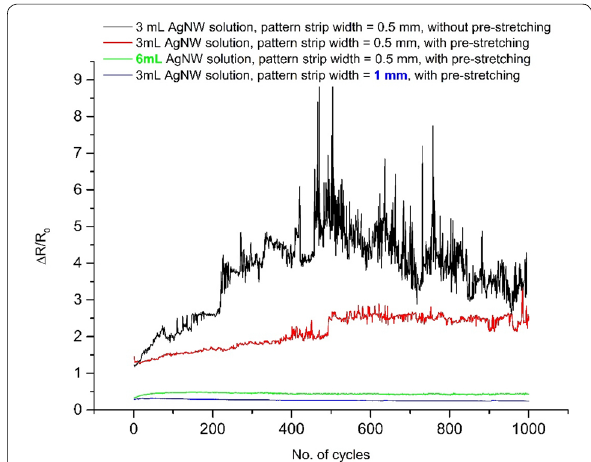
Fig. 5 The stability of sensor response, investigated through cyclic tests of stretching/releasing under 6 kPa pressure, was highly improved compared to the preliminary configuration (black), by increasing the width of the AgNW pattern (blue) and by increasing the amount of AgNW deposited (green). Each effect is independently shown, although both were preceded by pre-stretching. The effect of pre-stretching only is shown in red